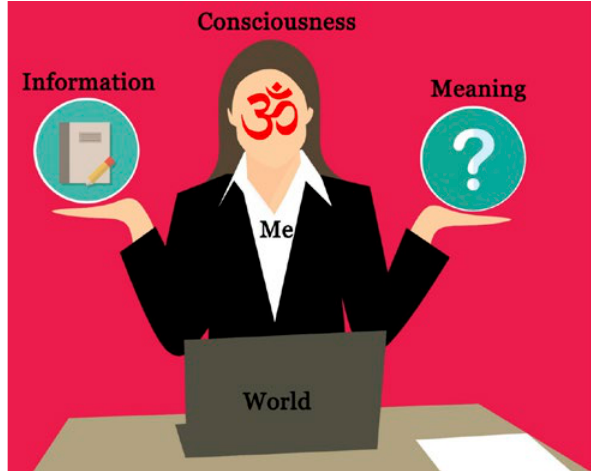
Figure 3. A pictorial representation of a conscious being (Me), represented here as a body and a Mind living in a material world, and using its consciousness to give meaning (?) to information rep- resented by a pen and a book. Consciousness has been symbolized on the head of the conscious being by the mantra “Om”, the cosmic sound of Atman, identical in essence with Brahman, the Self, the only reality (in